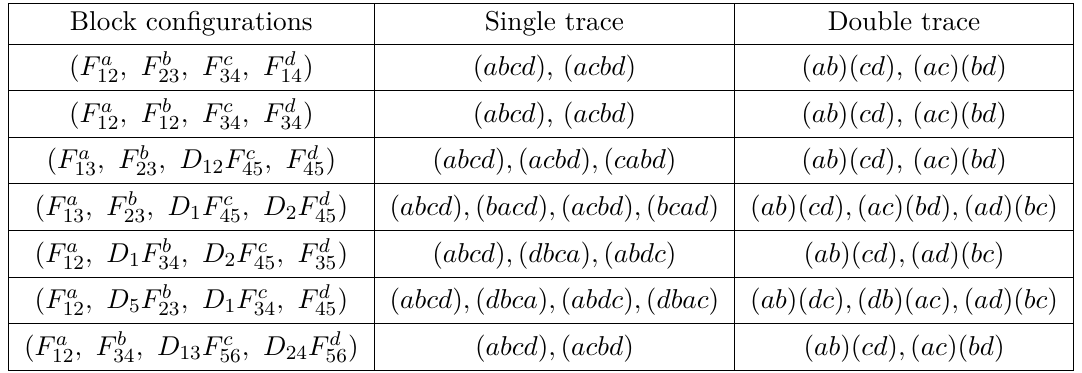
Table 1 . Primitive operators in the length-4 case. a, b, c, d are color indices and brackets ( a . . . d ) is short for Tr( T a . . . T d )